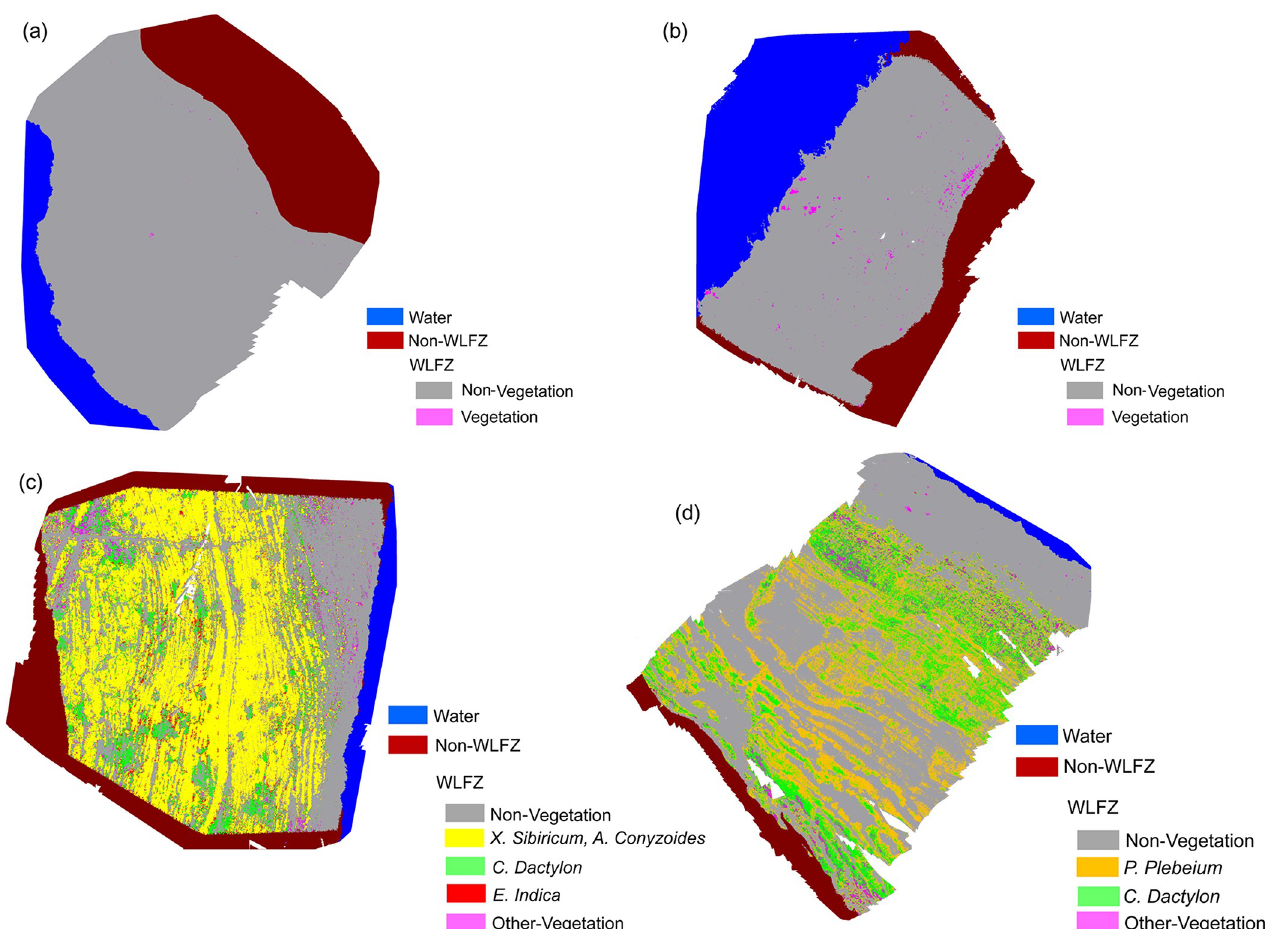
Fig 6. Classification results in the WLFZ of (a) Huangdeng study area 1, (b) Huangdeng study area 2, the (c) Nuozhadu study area, and the (d) Xiaowan study area.